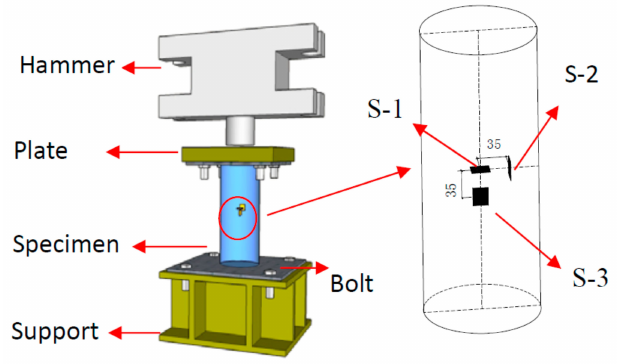
Figure 3. Location of the PVDF smart sensors.